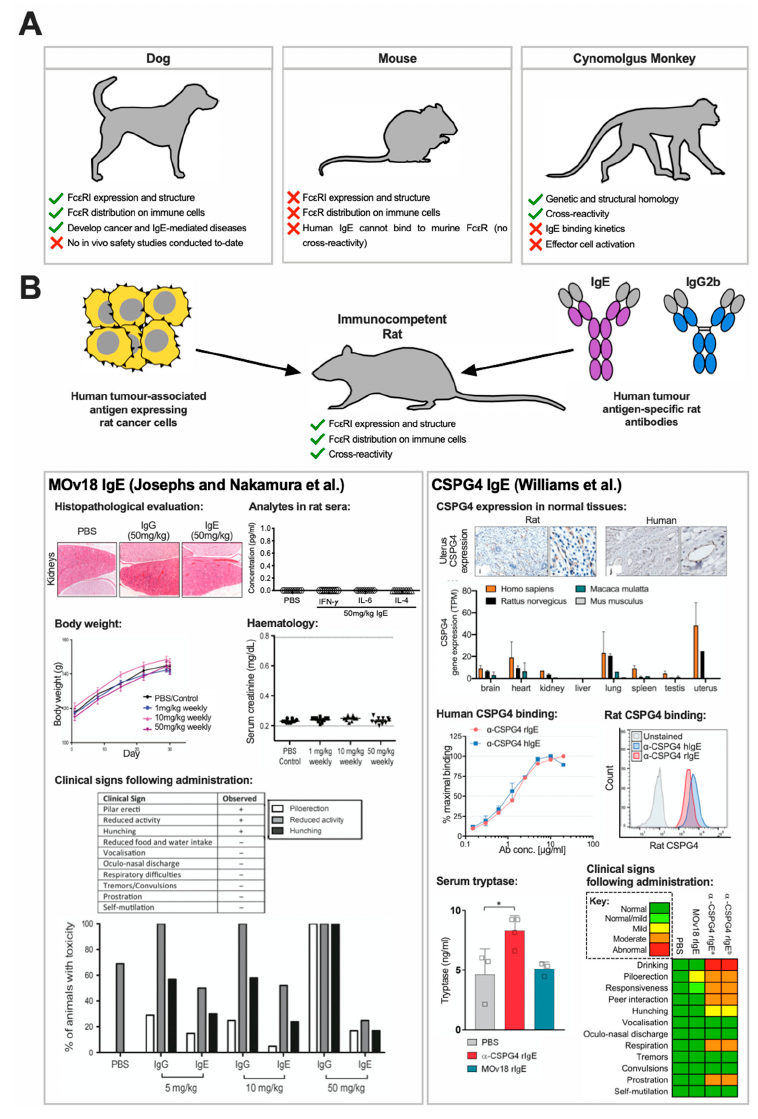
Figure 3. In vivo models for safety evaluations of IgE therapeutics. ( A ) IgE receptor expression and structure and distribution on immune cells, IgE binding cross-reactivity and kinetics, and IgE-associated biology across a number of species was compared with human to select the most appropriate model. ( B ) Due to similarities in IgE biology between rat and human, immunocompetent rats were used to study the safety of rat surrogate antibodies. Josephs et al. demonstrated safety of rat MOv18 IgE in immunocompetent rats challenged with human FR α -expressing CC531 cells. With treatment there were no significant changes in off-target organs (assessed by histopathology; representative images from kidneys shown), cytokines associated with hypersensitivity or cytokine storm, animal body weight and blood chemistry or haematological observations (serum creatine measurements shown). Furthermore, despite observations of some mild clinical signs of toxicity, these were short-lived and equivalent to those observed the counterpart rat MOv18 IgG antibody. Similarly, Williams et al. confirmed comparable expression profiles of human and rat CSPG4 on normal tissues (assessed by immunohistochemistry (representative images from uterus shown) and gene expression) and cross-reactivity of rat anti-human CSPG4 IgE to both human CSPG4 (on human melanoma A2058 cells) and rat CSPG4 (on rat glioma C6 cells). Following treatment with rat anti-CSPG4 IgE, mild elevation in serum tryptase was observed alongside observations of transient and mild clinical signs of toxicity (irrespective of rats having been challenged with human CSPG4-expressing CC531 cells (a) or untransfected CC531 cells (b)). Adapted from Josephs and Nakamura [67] and Williams et al. [83]. * p <